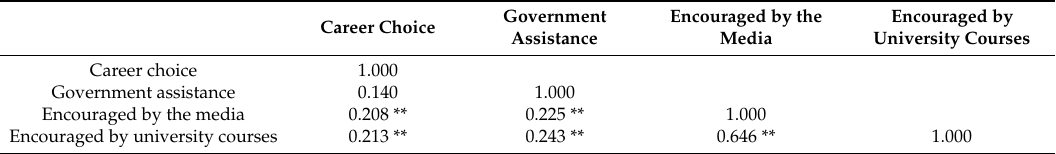
Table 9. Inter-correlation between perception about career choice and environmental factors.